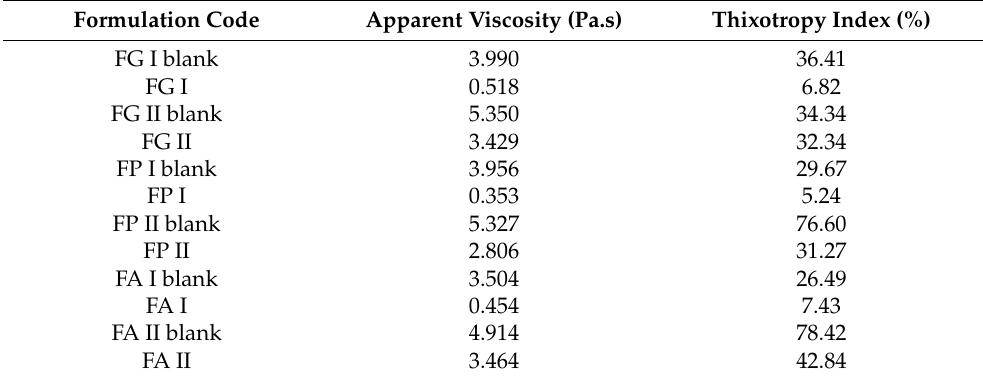
Table 3. Apparent viscosity and thixotropy index of experimental